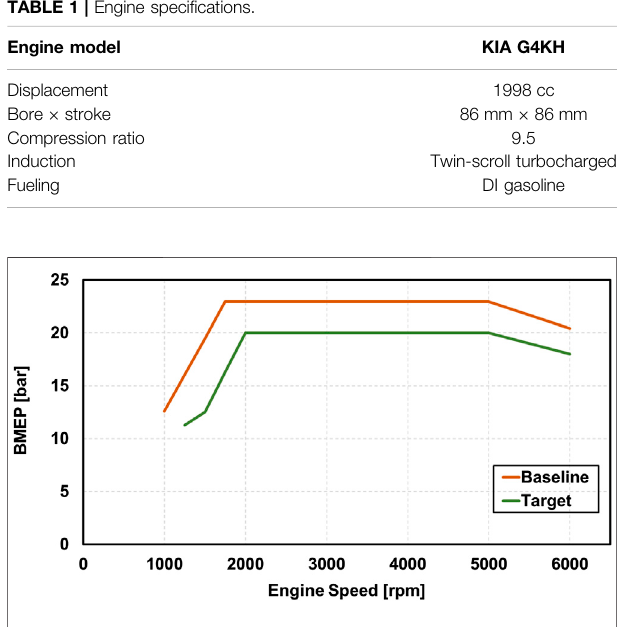
FIGURE 2 | Baseline and proposed performance curves.